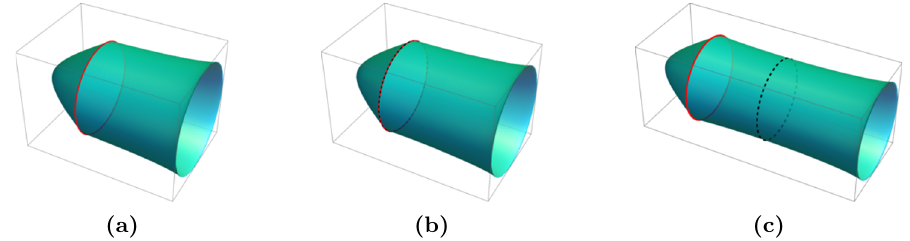
Figure 4 . Embedded geometry of the solution with matter shell (red circle) for three cases with the same total mass. In case (a), we have a ‘star-like’ con(cid:12)guration where the throat is capped o(cid:11) before reaching the narrowest point. Case (b), were the shell is placed at the narrowest point of the throat, resembles a microstate geometry. Case (c), where the throat is capped o(cid:11) beyond its narrowest point, does not have a counterpart in the black hole